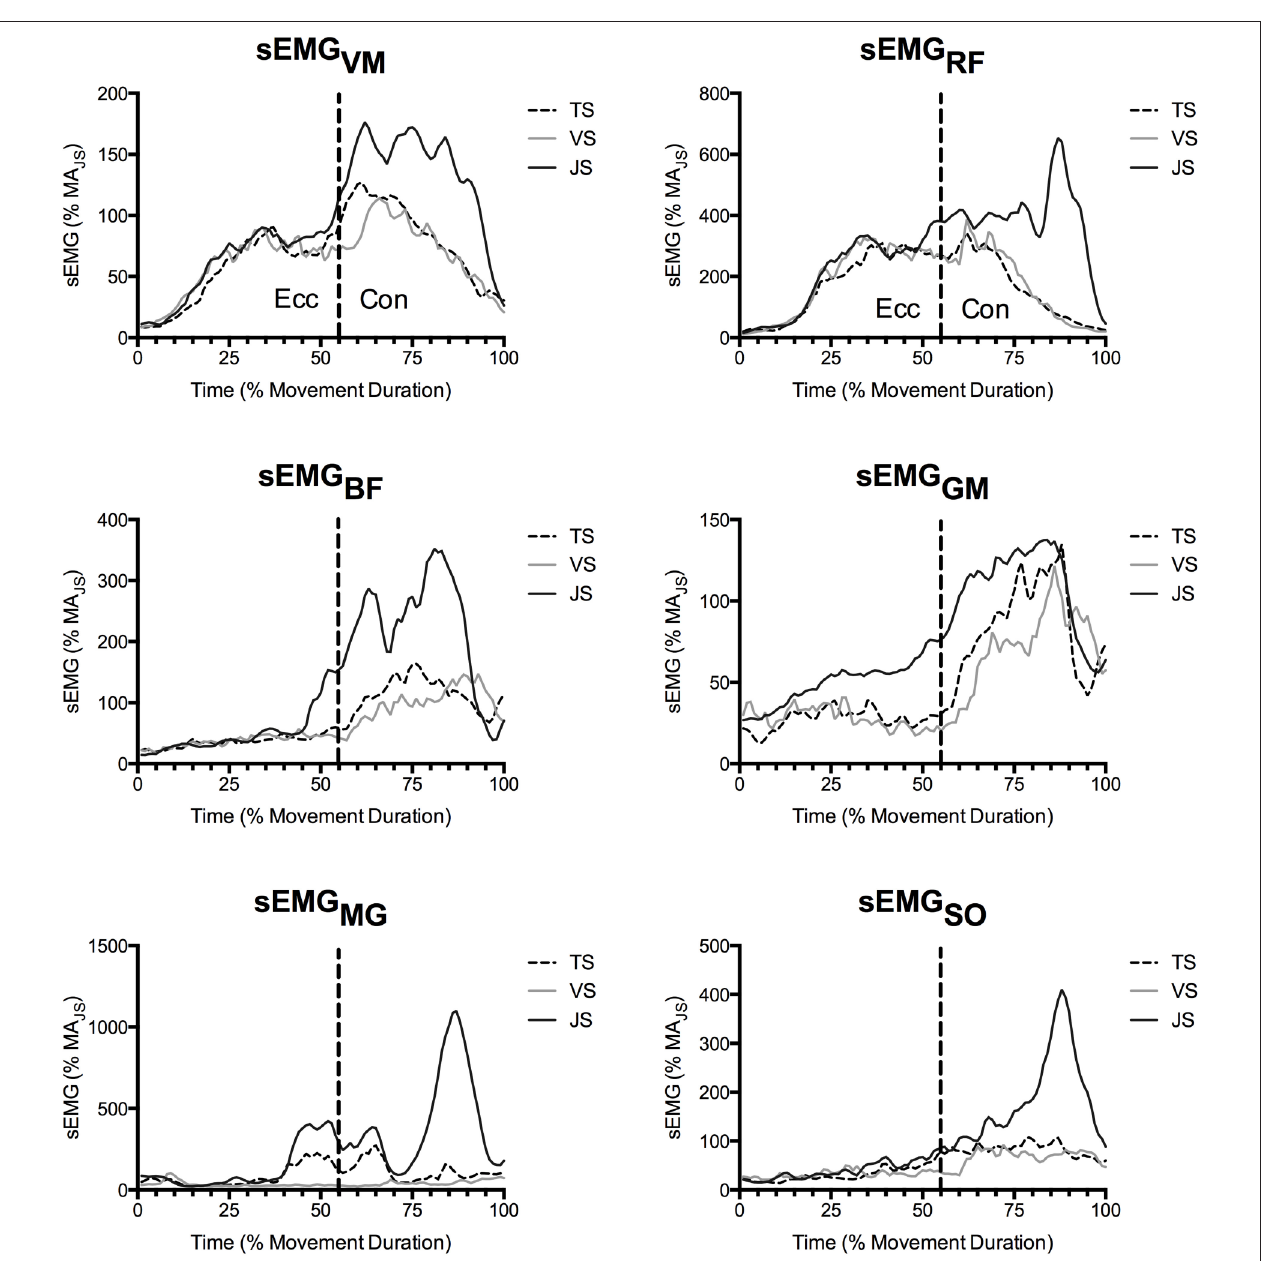
FIGURE 5 | Mean muscle activity of the vastus medialis (VM), rectus femoris (RF), biceps femoris (BF), gluteus maximus (GM), medial gastrocnemius (MG), and soleus (SO) as recorded by surface EMG ( n = 10). Values are presented as a percentage of muscle activity during an unloaded jump squat.